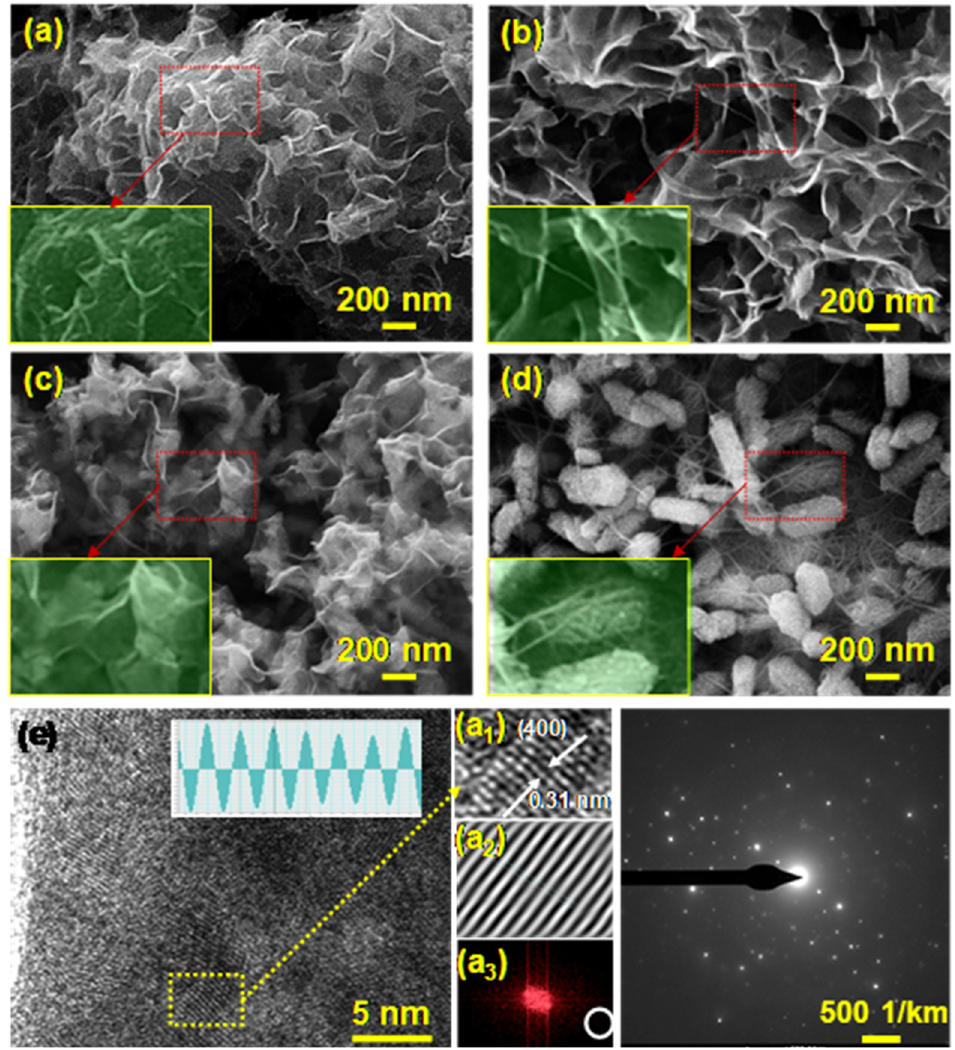
Figure 4. FESEM images corresponding to the sample ( a ) INS0, ( b ) INS1, ( c ) INS2, and ( d ) INS5, ( e ) HRTEM image, and ( a1 ) their magnified areas, which are illustrated by ( a1 ) FFT line, ( a2 ) FFT images, and ( a3 ) SAED pattern for INS1 sample.